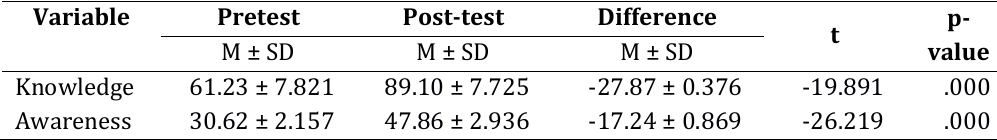
Average knowledge and awareness